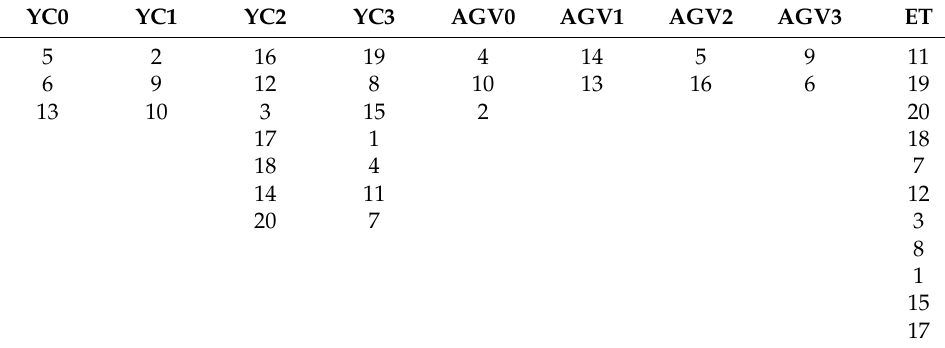
Table A2. Numerical experiment: allocation result of each